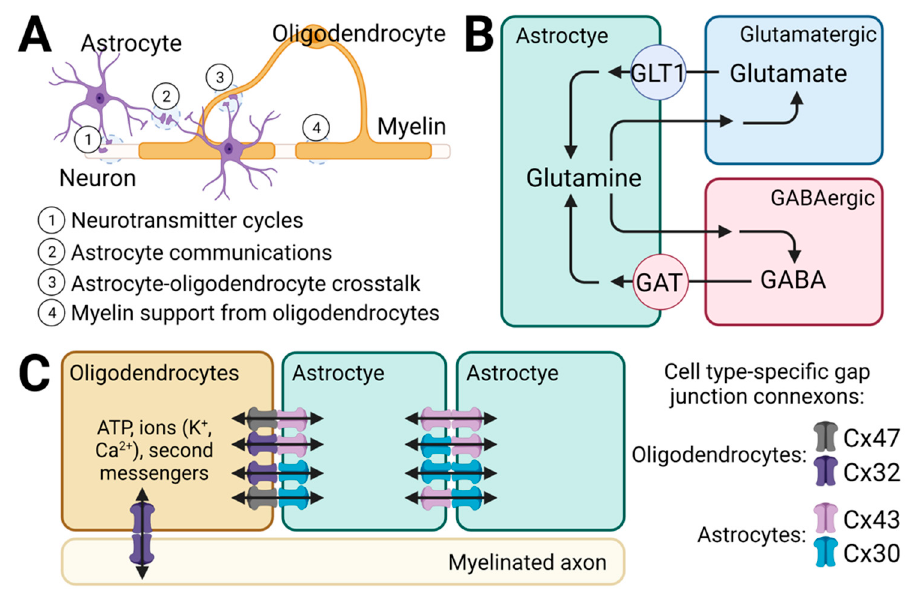
Figure 4. Astroglial-mediated mechanisms in neural cell communication. ( A ) Glial cells mediate a wide range of neuro- physiological processes: (1) neurotransmitter cycles between astrocytes and neurons, (2) astrocyte communication, (3) crosstalk between astrocytes and oligodendrocytes, (4) oligodendrocyte-derived myelin enwrapping neurons. ( B ) Sche- matic diagram showing the neurotransmitter cycles. Excitatory (glutamate) and inhibitory (GABA) neurotransmitters reuptake into astrocyte via the glutamate transporter (GLT1) and the GABA transporter (GAT), respectively. Both neuro- transmitters are metabolized to glutamine and are recycled back to glutamatergic and GABAergic neurons for the synthesis of their respective neurotransmitters. In SSADHD, pathologic accumulation of GABA likely has a direct impact on astrocyte recycling, contributing to astrocyte dysfunction. Glutamine reduction is observed in SSADHD patients and in the mouse model. ( C ) Astroglial communications are mediated by gap junctions which are made of cell type-specific connexons. Gap junctions mediate rapid exchange of small molecules including ATP, ions, and second messengers. Astrocyte dysfunction in SSADHD might manifest into a wide range of pathophysiological processes involving the vast astrocyte–oligodendrocyte–neuronal network amplified by gap junction abnormalities.